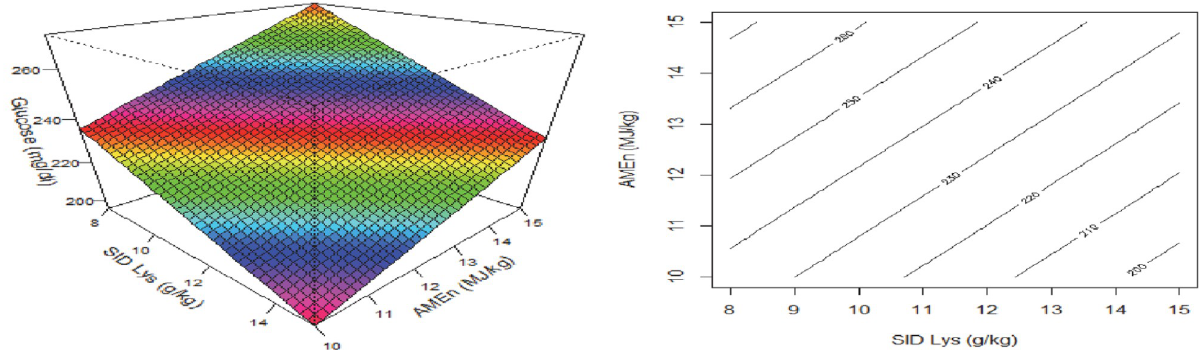
Fig 7. Response surface and contour describing relationships between blood glucose concentrations with dietary energy density and digestible lysine in broiler chickens.